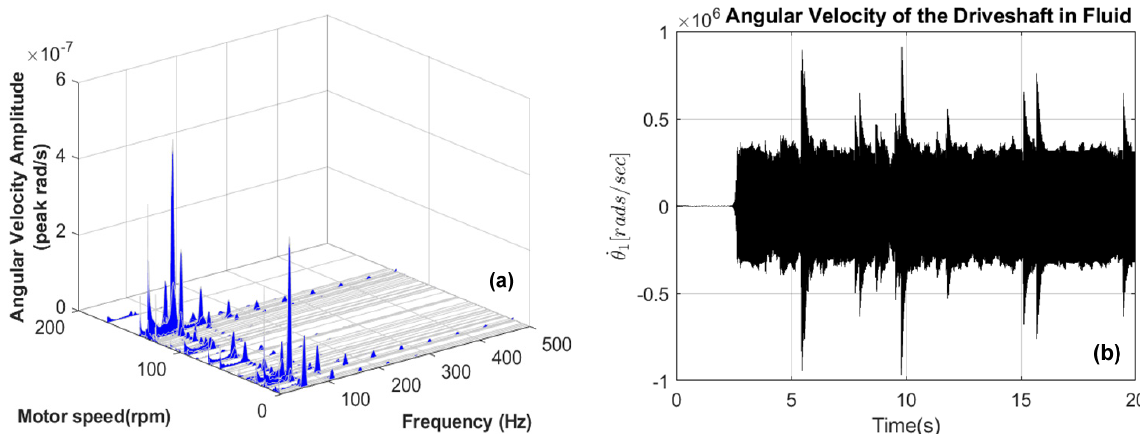
Figure 13. The 3 ‐ D driveshaft frequency spectrum of angular velocity during acceleration inside fluid ( a ) Motor speed variation frequency ( b ) Angular velocity vibration of the unbalanced and rubbing driveshaft.